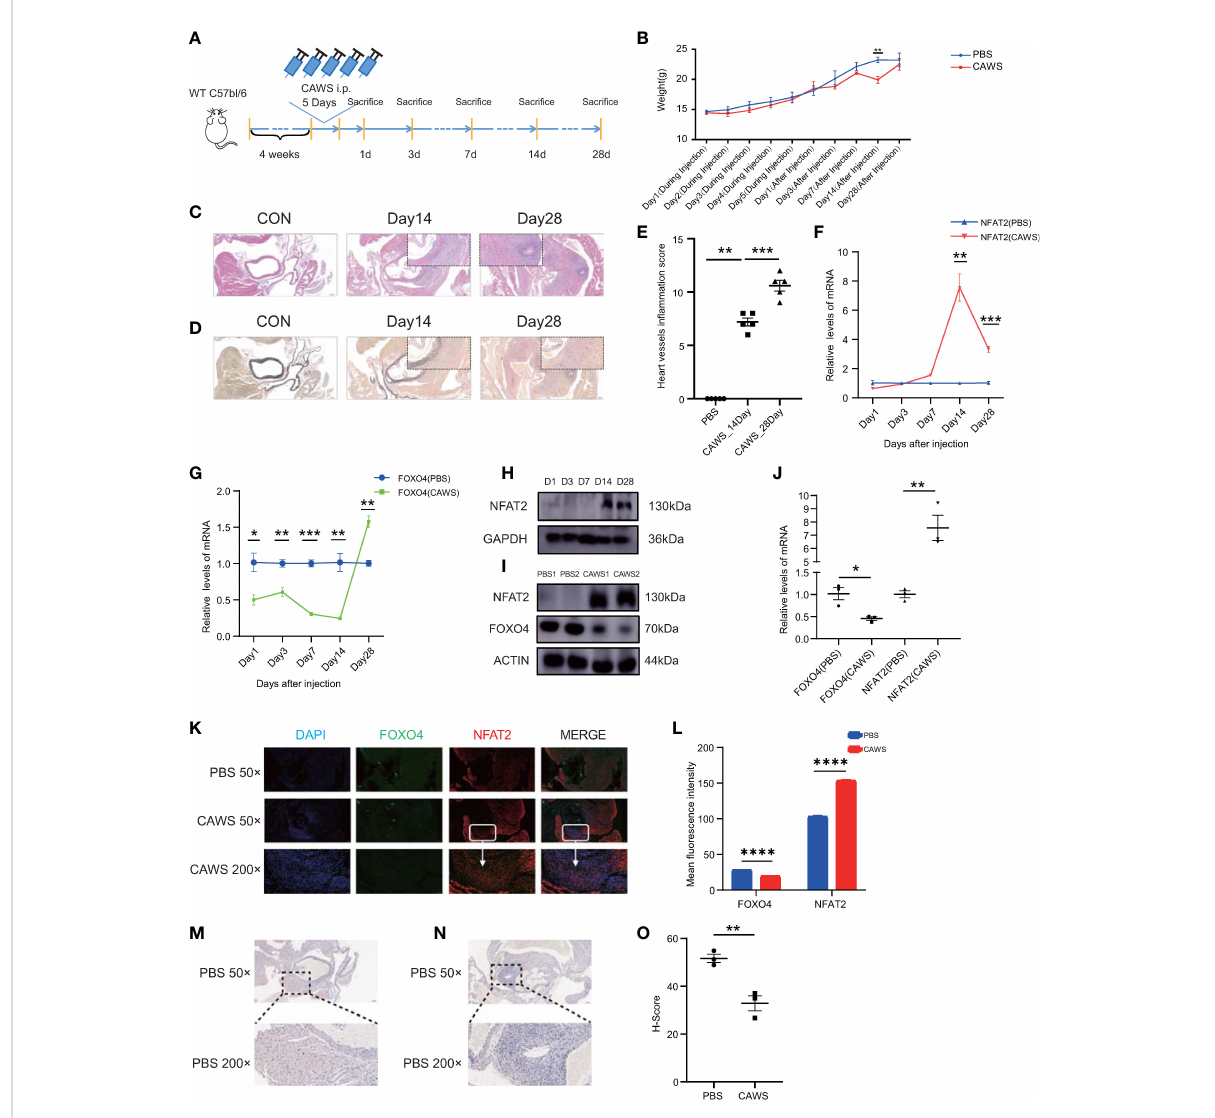
FIGURE 5 NFAT2 expression levels are upregulated during the progression of CAWS-induced vasculitis. (A) The protocol for constructing the CAWS- induced mouse model. (B) The change of weight during (n = 5) and after (n = 5) PBS/CAWS injection in mice. (C, D) At different timepoints the mouse were sacri fi ced, heart tissues were harvested, made into sections, and subjected to hematoxylin and eosin (HE) staining (C) and elastic van Gieson (EVG) staining (D) . Scale bars, 200 µm (50×) (Large) and 10 µm (200×) (Small). (E) Scores of heart vessel in fl ammation for WT mice injected with CAWS (n = 5). (F – H) NFAT expression was signi fi cantly upregulated at 14 – 28 days after CAWS injection, at the mRNA level in PBMCs (n = 3) (F) and at the protein level in heart tissues (H) , especially after 14 days. (G) The mRNA expression of Foxo4 was almost opposite to that of Nfat2 in PBMCs (n = 3). (I, J) NFAT expression was upregulated and that of FOXO4 was downregulated in heart tissues at 14 days after CAWS injection at both protein (n = 3) (I) and mRNA (J) levels. (K) Immuno fl uorescence imaging of FOXO4 (green) and NFAT2 (red) in heart sections from PBS/CAWS-injected 14 days WT group mice. Scale bars, 200 µm (50×) and 10 µm (200×). All images show DAPI staining of nuclei. (L) Mean fl uorescence intensity of FOXO4 and NFAT2 in heart sections from PBS/CAWS-injected 14 days WT group mice. (M – O) Immunohistochemical staining for CDH5 in heart sections from PBS-injected (M) and CAWS-injected (N) WT group mice. CDH5 protein levels quanti fi ed using the H-score (O) (n = 3). Data are presented as the mean ± SEM. Quantitative data were analyzed using unpaired t tests (two- tailed) (B, F, G, J, L, O) and the Mann – Whitney test (two-tailed) (E) *P < 0.05, **P < 0.01, ***P < 0.001, ****P <